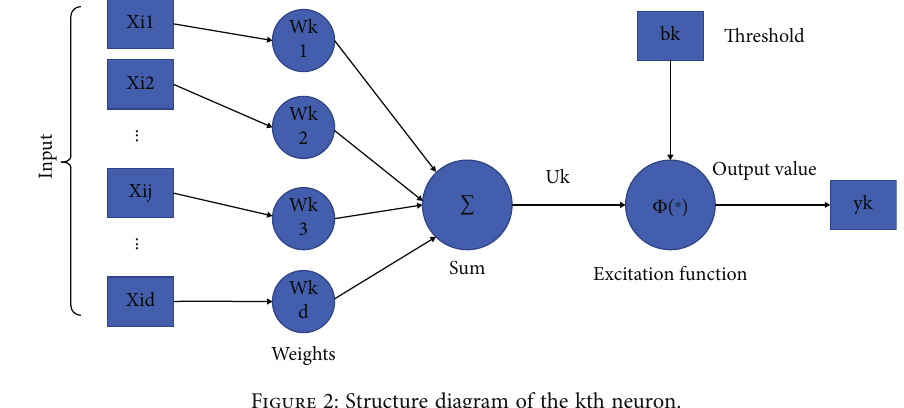
Figure 2: Structure diagram of the kth